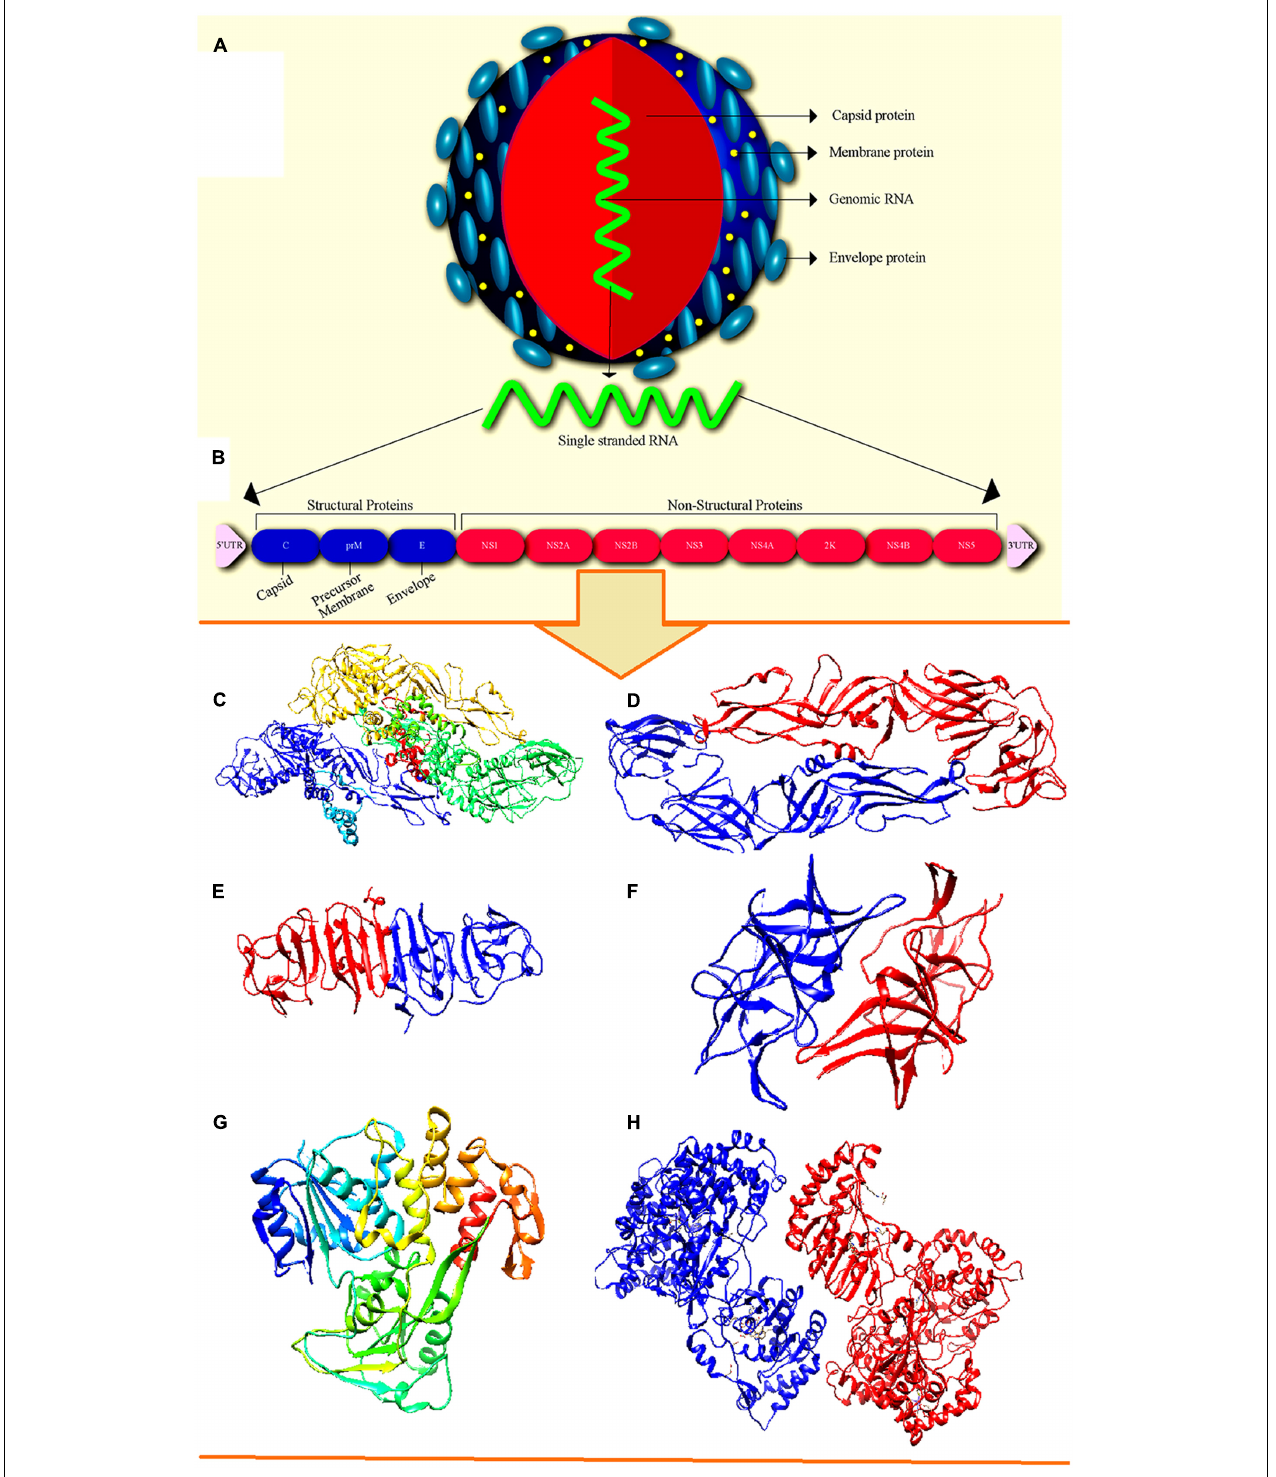
FIGURE 1 | Structure of Zika virus (ZIKV). (A) Ultra structure of ZIKV with major surface proteins. (B) Genomic RNA of ZIKV exhibiting major structural and non-structural proteins. The crystal structure of available structural and non-structural protein of ZIKV. (C) The cryo-EM structure of ZIKV (PDB: 5IRE). (D) Structure of envelop protein (PDB: 5JHM). (E) Structure of NS1 protein (PDB: 5IY3). (F) Structure of the NS2b–NS3 complex (PDB: 5GXJ). (G) Structure of NS3 helicase (PDB: 5JPS). (H) Structure of NS5 protein (PDB: 5U0B).